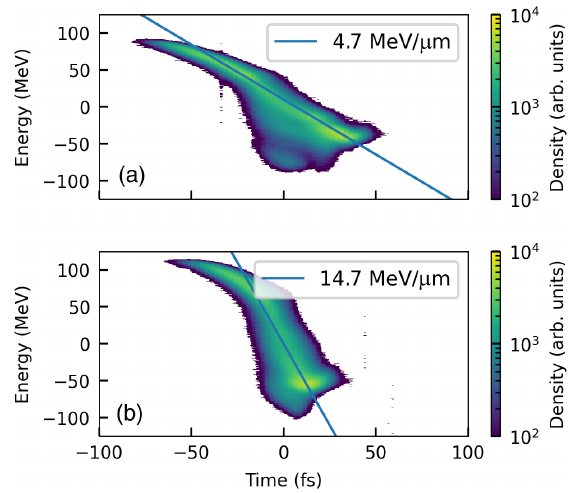
FIG. 7. Representative XTCAV images are shown for 4.7 (a) and 14.7 (b) MeV = μ m chirps. In each case, the beam has undergone lasing that is evident from the energy loss around 0 fs. Blue lines give estimates of the linear chirp in the lasing